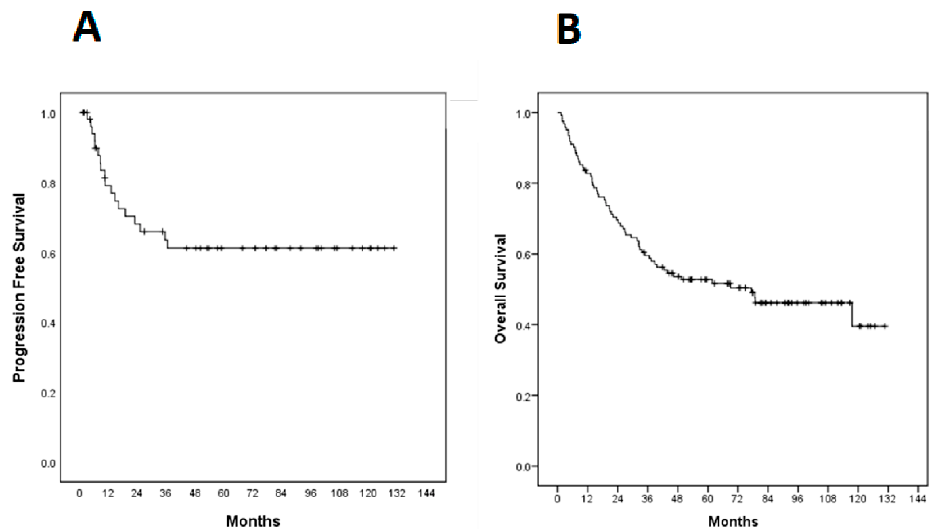
Figure 2. Kaplan–Meier curves in 122 cases. ( A ) Progression-free survival (PFS); ( B ) Overall survival (OS).